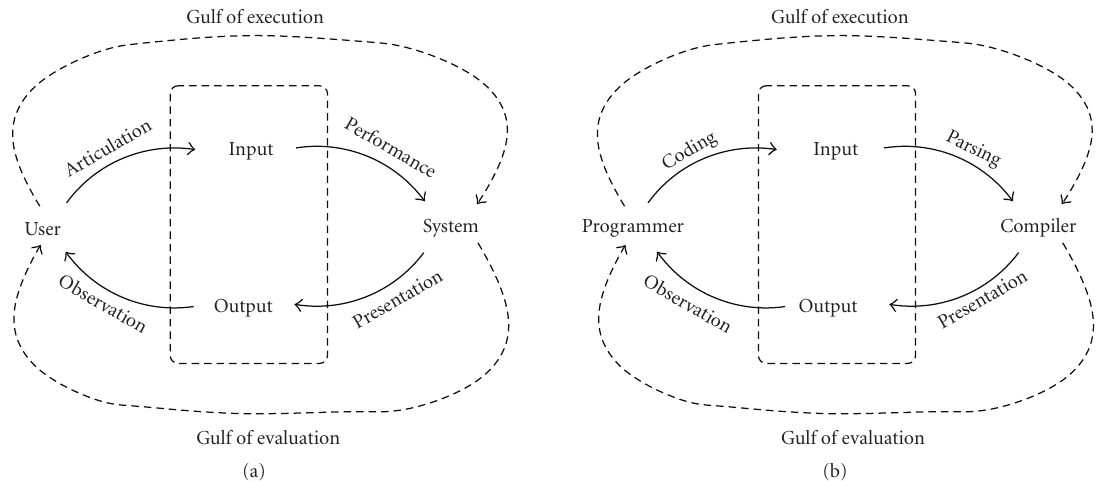
Figure 1: The interaction framework: (a) general proposal [52]; (b) our instantiation to a compiler environment. The gulfs of execution and evaluation [53] have been